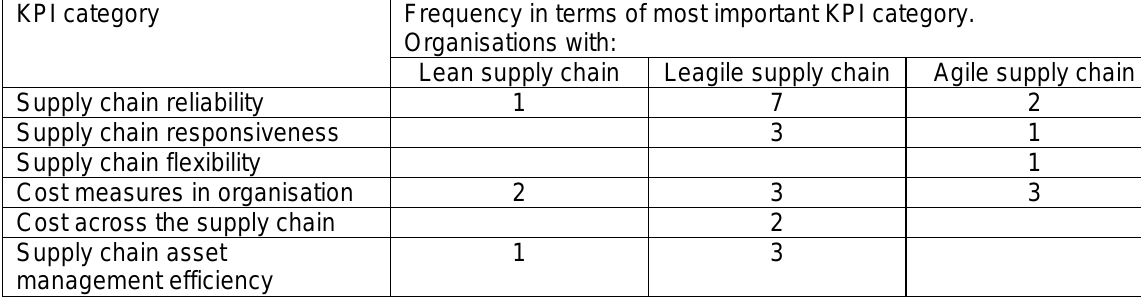
Table 10: Top KPI categories for organisations ( n = 13) KPI category Frequency in terms of most important KPI category. Organisations with: Lean supply chain Leagile supply chain Agile supply chain Supply chain reliability 1 7 2 3 1